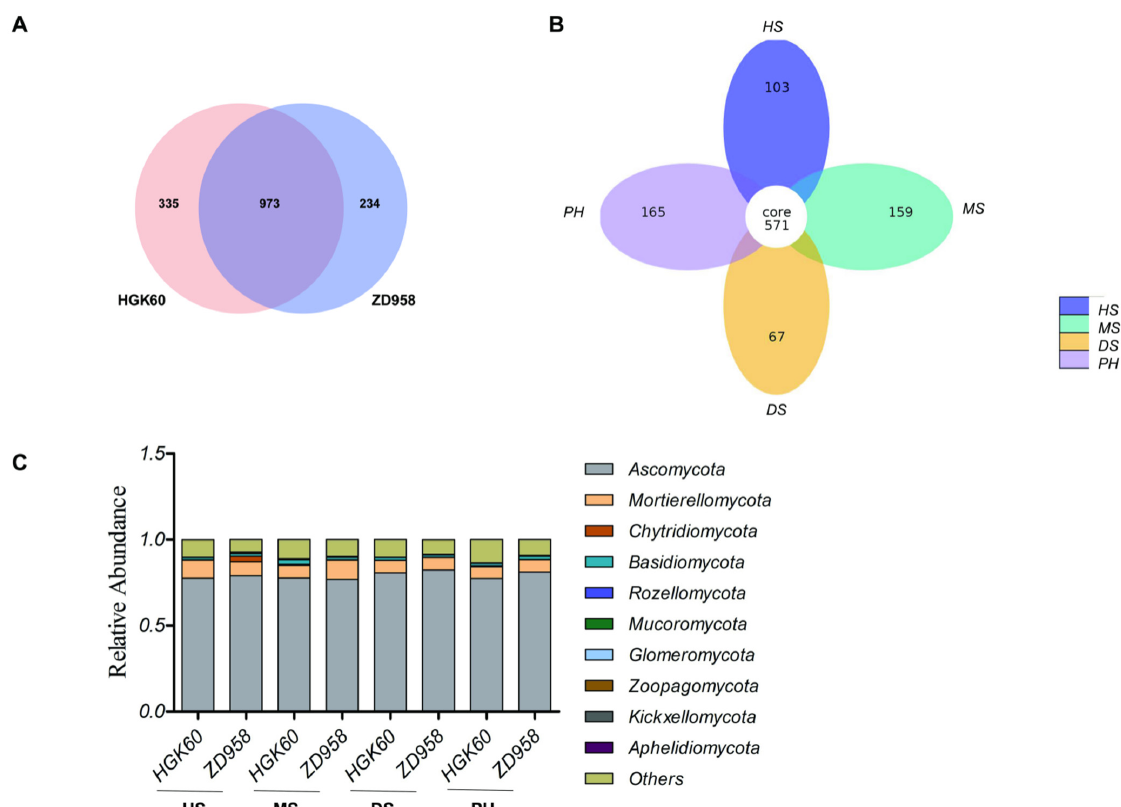
Figure 4. The composition of fungal community in the rhizosphere soil of HGK60 and ZD958. ( A ) Venn diagram showing variable overlaps between HGK60 and ZD958; ( B ) Venn diagram showing variable overlaps between four growth stages; ( C ) relative read abundance of fungal phyla classes within the communities. The numbers in ( A , B ) within the circles represent the operational taxonomic units (OTUs). HS—heading stage, MS—milk stage, DS—dough stage, and PH—post-harvest stage.